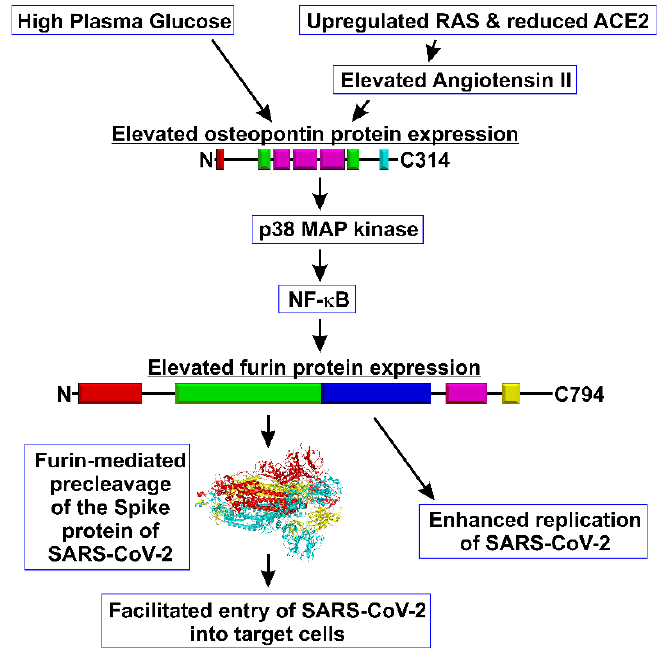
Figure 4. Diagram of the High Glucose–Osteopontin–Furin axis and its putative implication in regulating SARS-CoV-2 infection. Structure of the Spike protein of SARS-CoV-2 was redrawn using the atomic coordinates published in PDB ID: 6VXX.